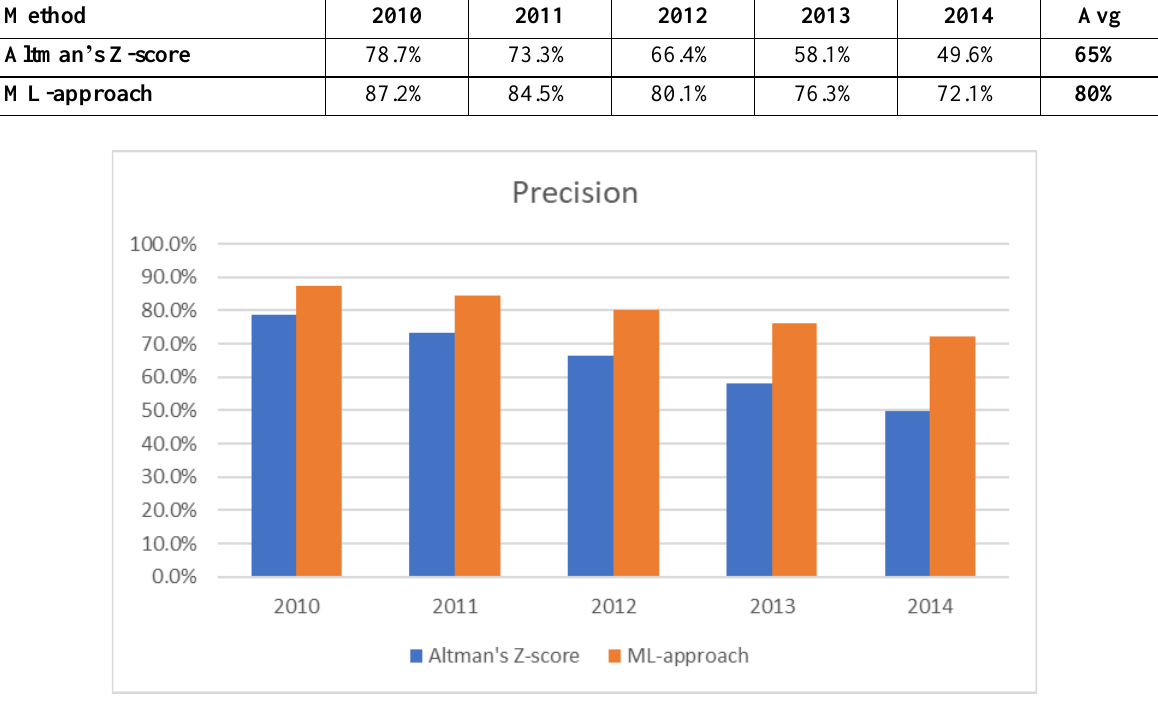
Figure 1. Precision: Altman’s Z-score vs